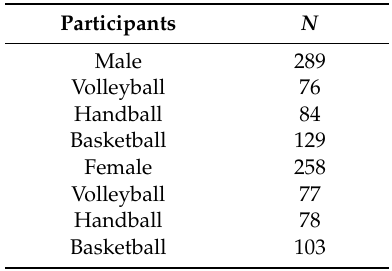
Table 1. Sociodemographic characteristics.